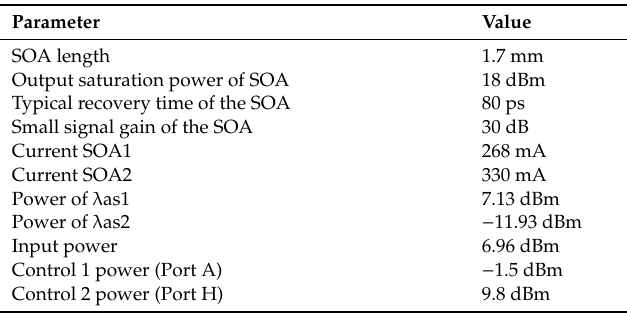
Table 1. Operational conditions of the BMWC.